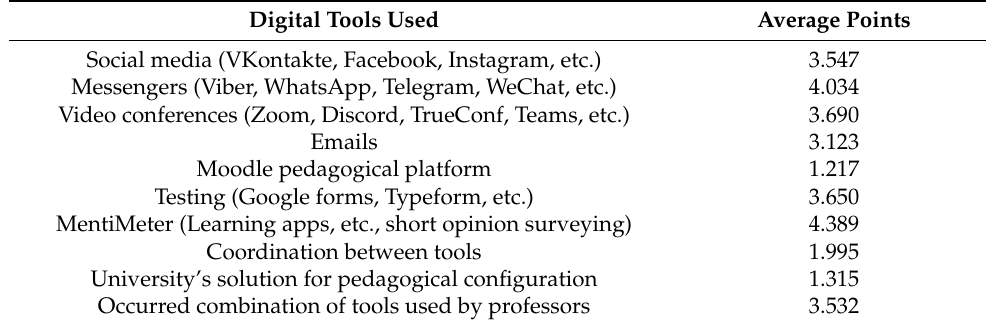
Table 2. Points awarded by students for digital tools applied during spring semester, September 2020 (N3 = 203). Digital Tools Used Social media (VKontakte, Facebook, Instagram,